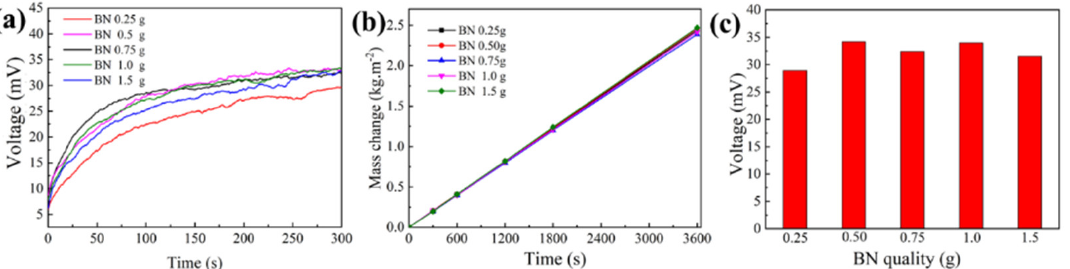
Figure 5. ( a ) Open circuit voltage; ( b ) Evaporation mass variation; ( c ) Maximum open−circuit voltage for different BN amounts in the cooling layer of the thermoelectric component.